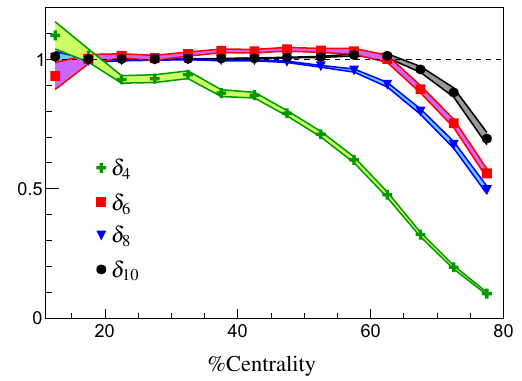
Fig. 6 The averaged flow harmonic estimator ¯ v 2 { 2 k } obtained from the ATLAS experimental data